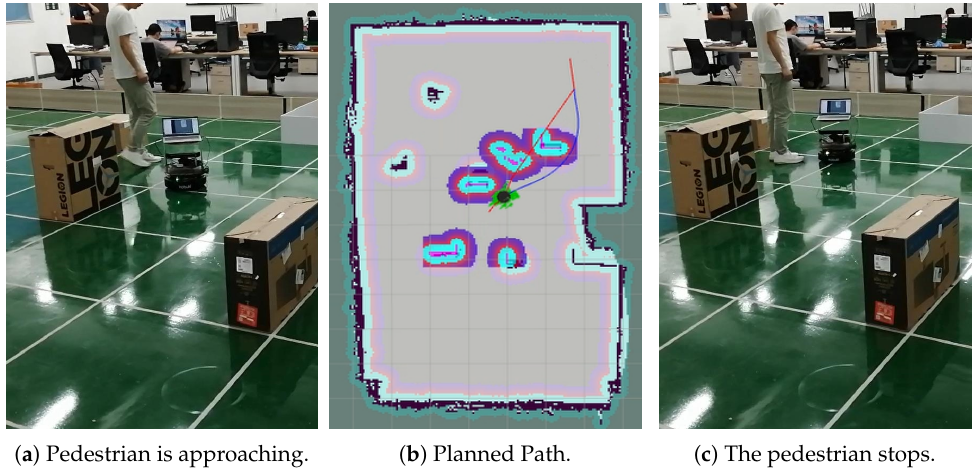
Figure 16. Snapshots of path planning in dynamic situation with a conservative walker.